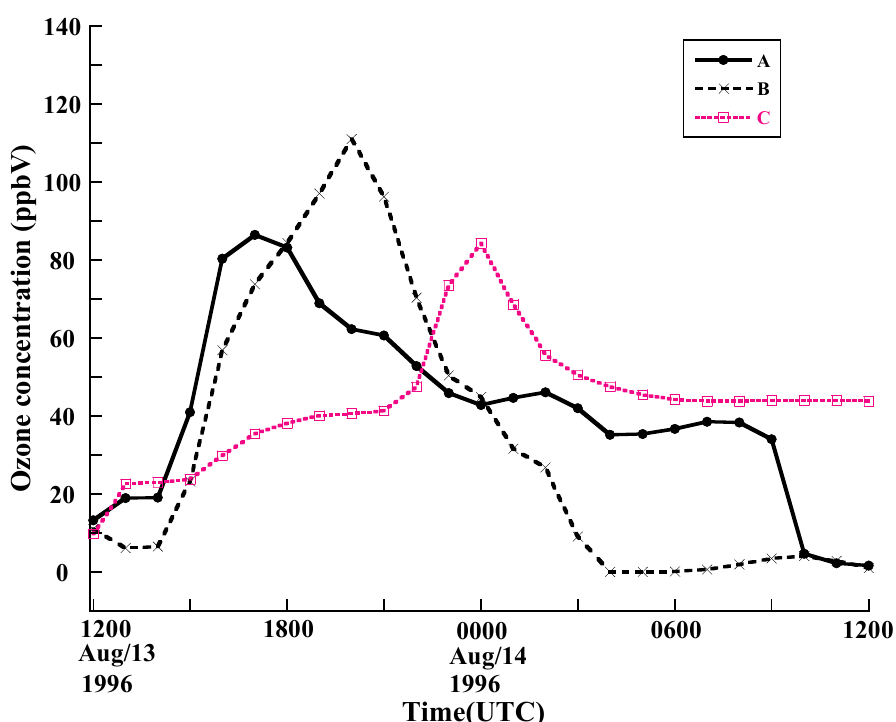
Figure 5. Comparison of surface ozone concentrations at Point A, B and C in Figure